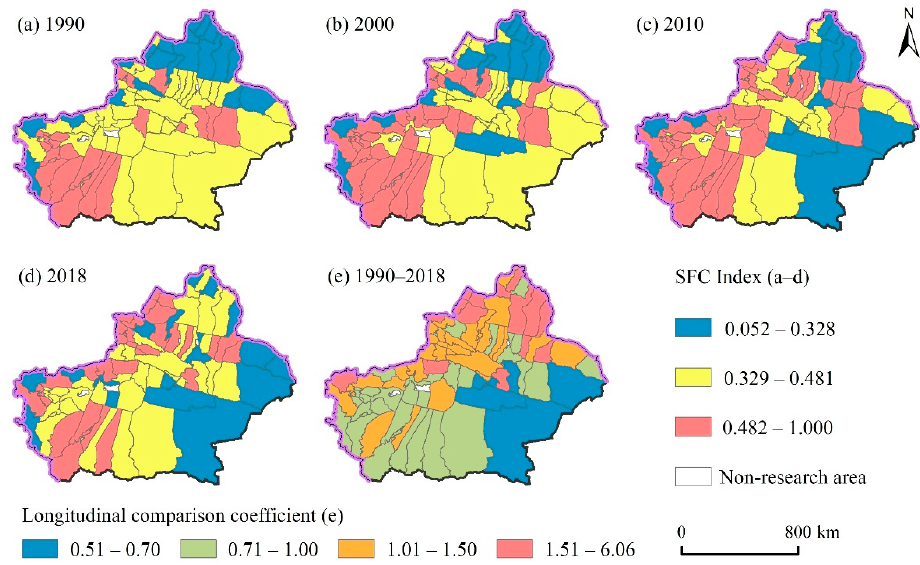
Figure 4. Temporal and spatial evolution of the SFC at the county level in Xinjiang from 1990 to 2018: ( a ) SFC in 1990; ( b ) SFC in 2000; ( c ) SFC in 2010; ( d ) SFC in 2018; and ( e ) Changes in SFC in 2018 compared to 1990.